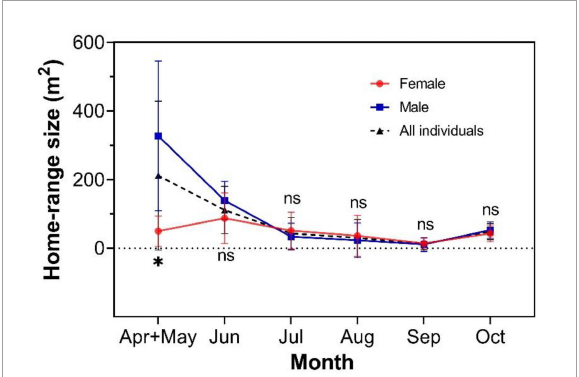
FIGURE2 Comparison of the sizes of the home range of males and females in different months. The average sizes of the home range of all individuals are represented by the black dotted line. The asterisk indicates a significant difference, and ns means no significant difference in the home ranges of males and females. The results are presented as mean ± SD